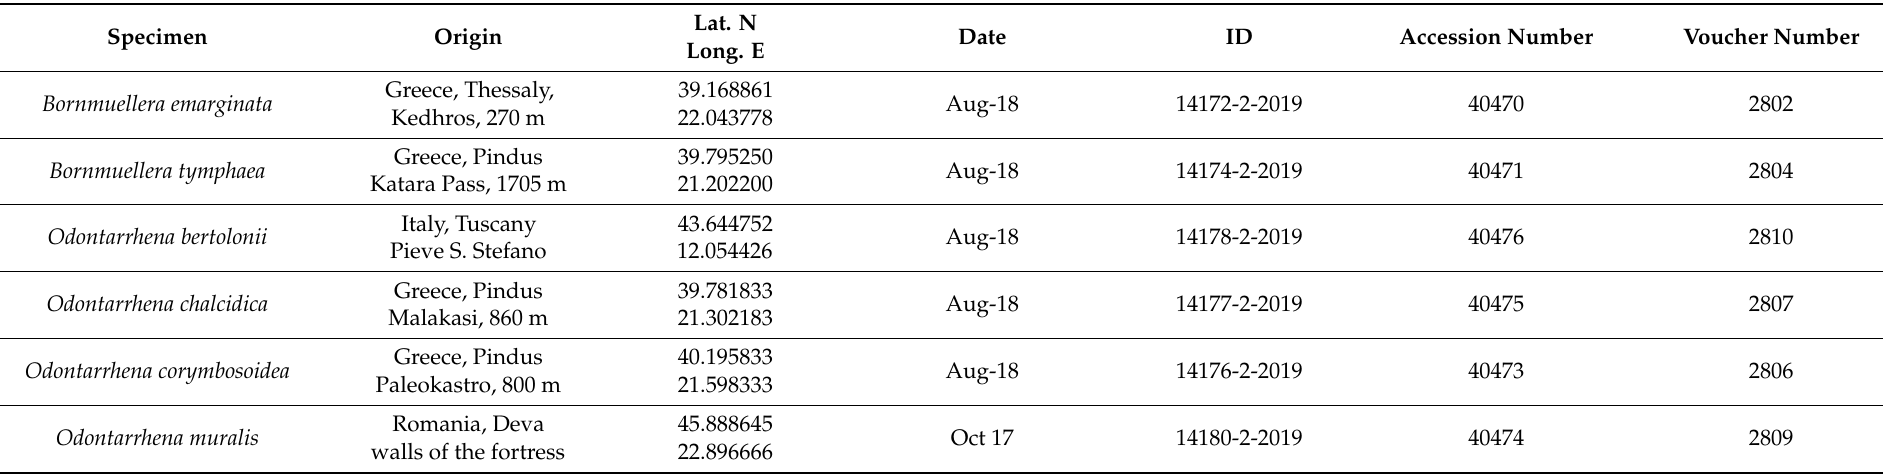
Table A4. Voucher information for species grown at the Bonn University Botanical Gardens. Each accession corresponds to. Standard, serpentine, and calcareous soils that will be vouchered in the